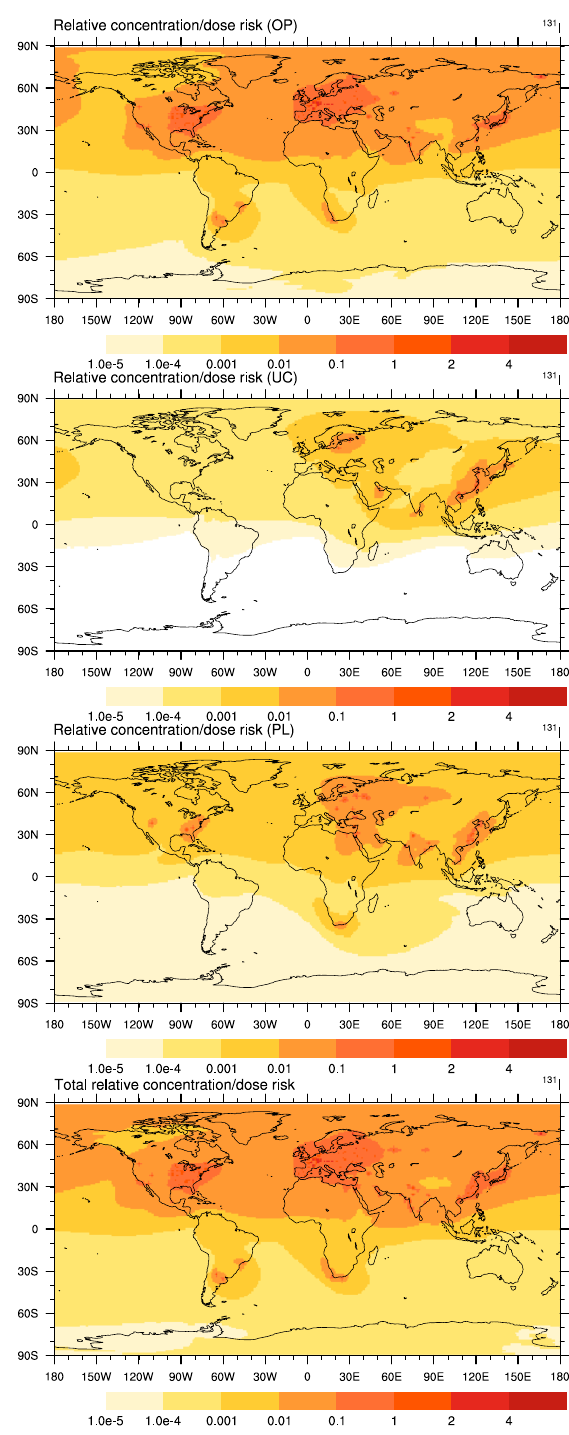
Fig. 2. Top to bottom: Operating, under construction, planned or proposed, and combined total nuclear power plant relative risk from global mean (years 2010–2030) 131 I surface layer concentration and equivalent daily effective dose to the public from inhalation.